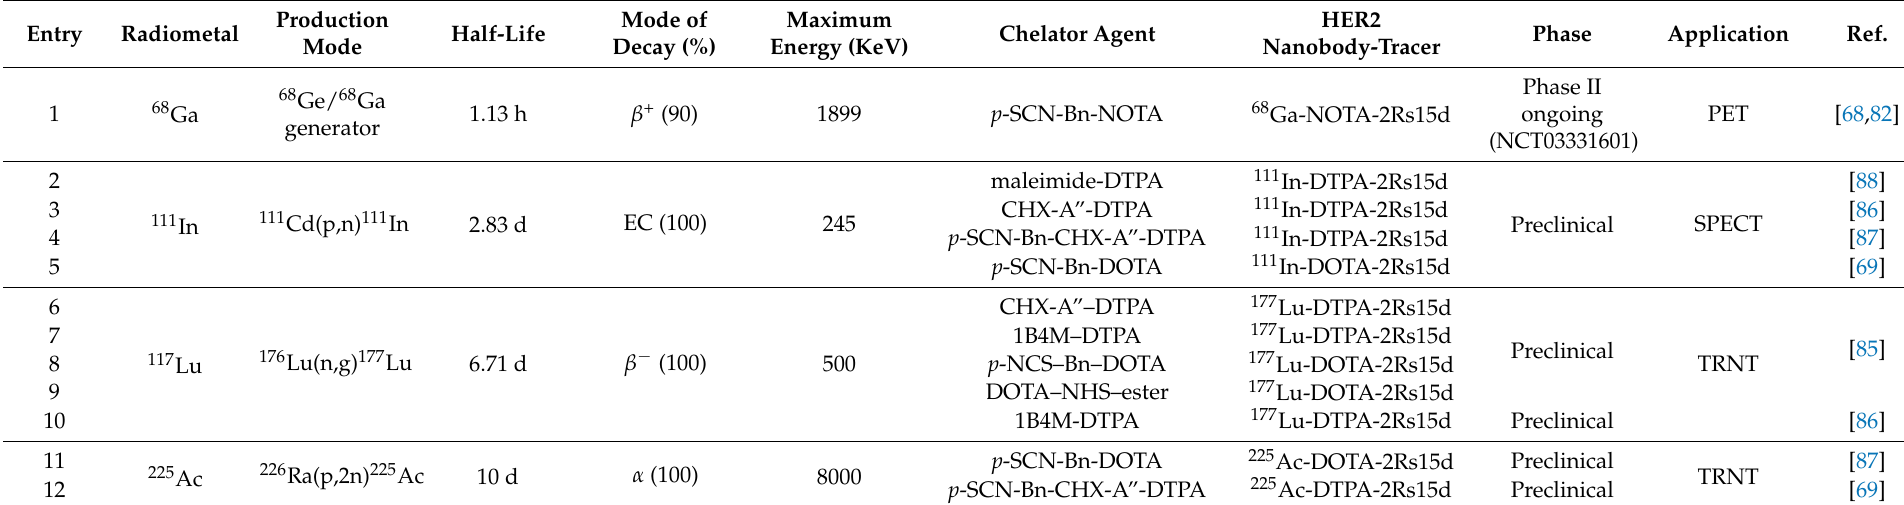
Table 3. HER2 + 2Rs15d Nb-based radiopharmaceuticals using different radiometals and chelating